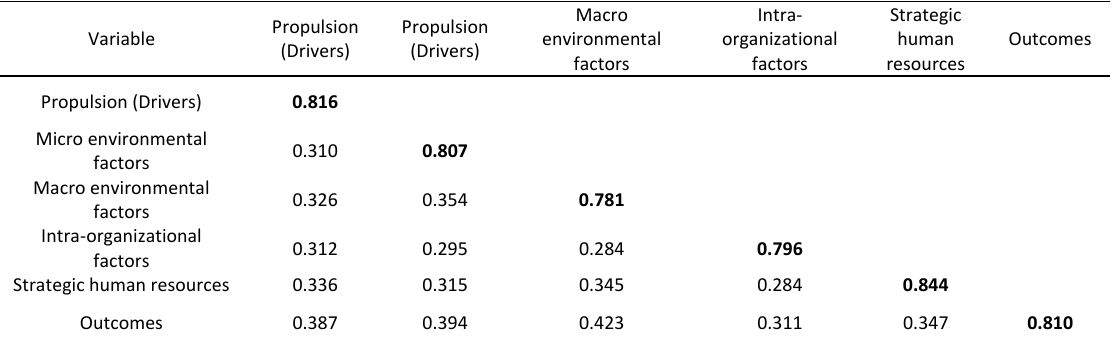
Table 3: The Divergent validity calculations